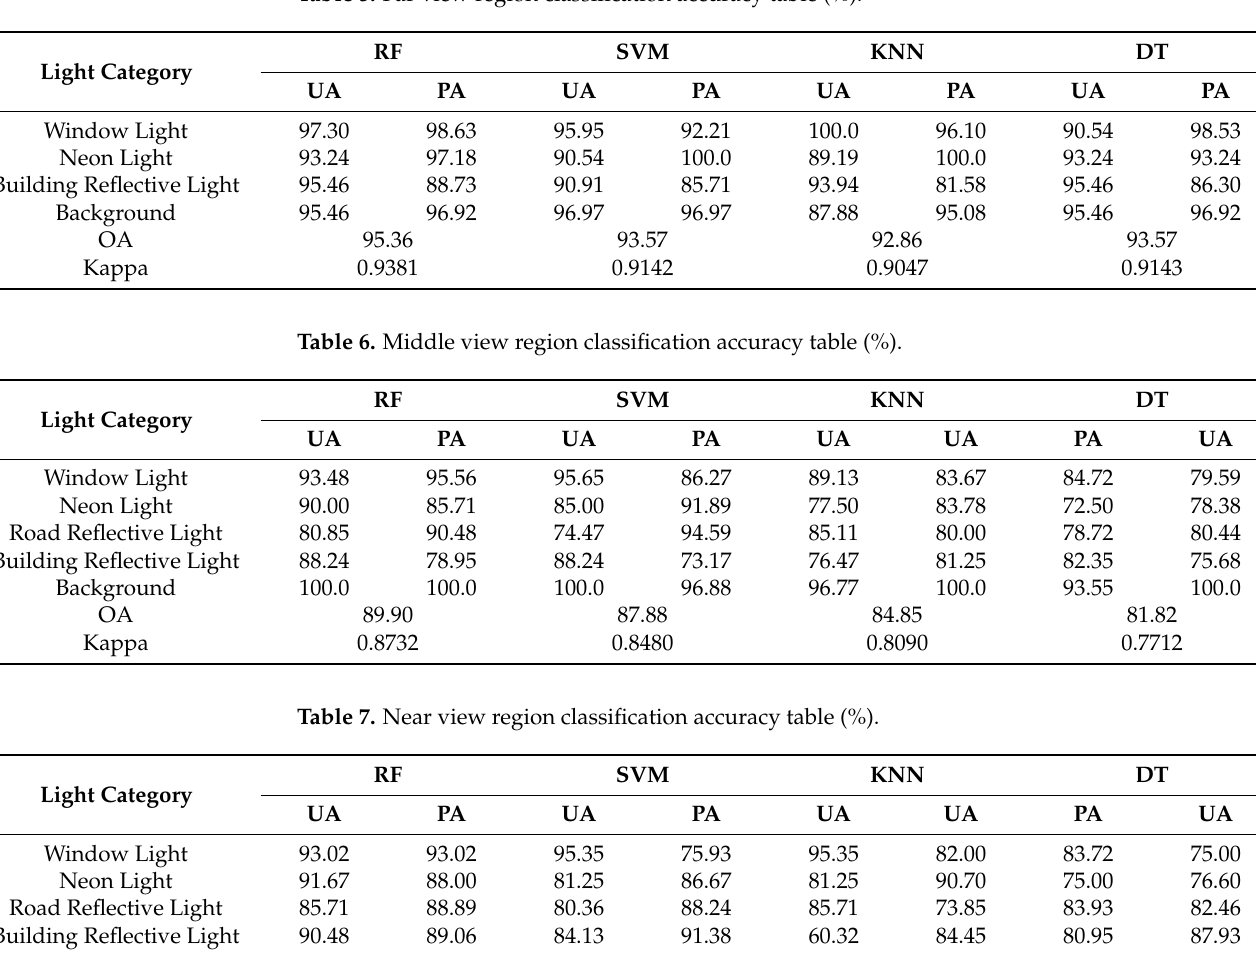
Table 5. Far view region classification accuracy table (%).